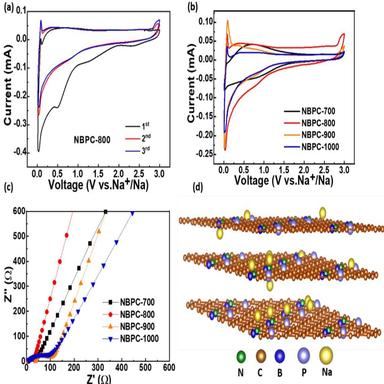
(a) CVs of NBPC-800 (b) NBPC-700 to NBPC-1000 at a scan rate of 0.1 mV s − 1 . (c) Nyquist plots of NBPC-700, NBPC-800, NBPC-900, and NBPC-1000. (d) Schematic diagram of Na+ diffusion within the defective sides of NBPC-800.